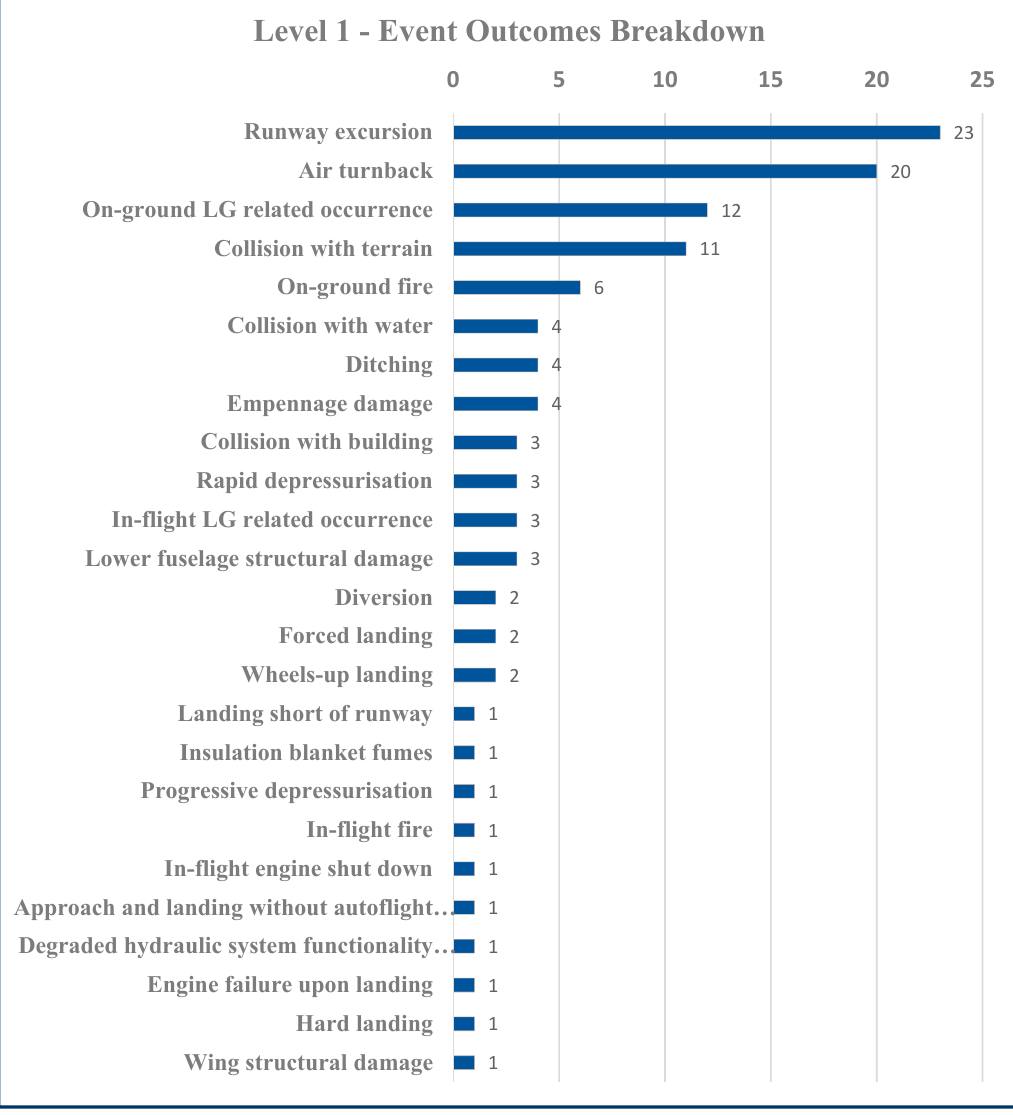
Figure 5. Level 1 top level event outcomes.